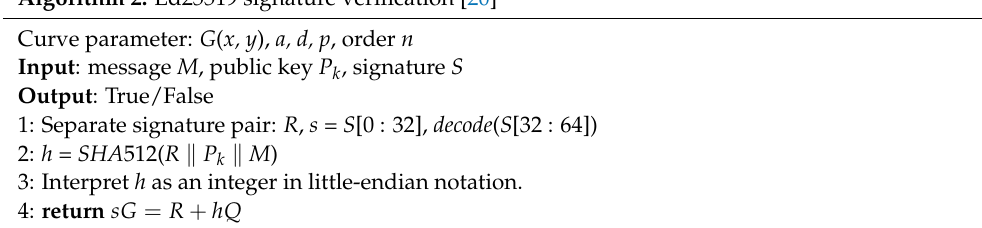
Algorithm 2. Ed25519 signature verification